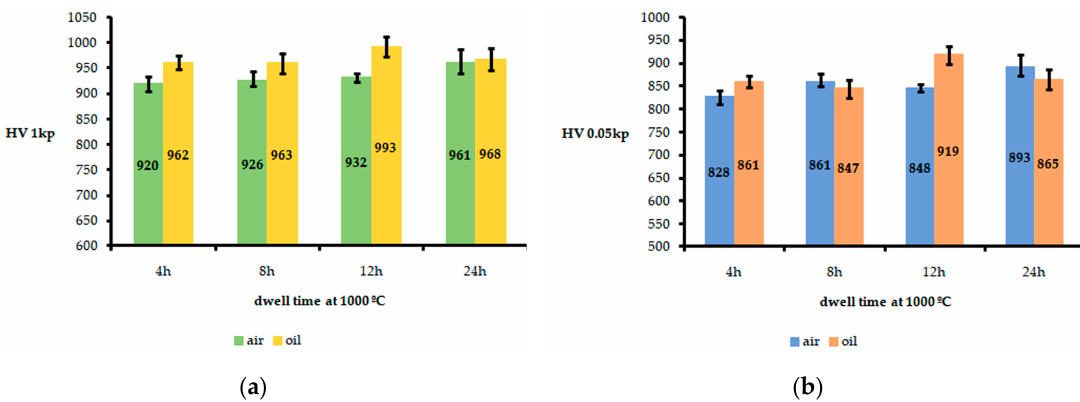
Figure 6. Hardness values. The error bars show the distance between the mean value and the maximum and minimum values. Ten (10) indentations were made in each sample; ( a ) hardness values obtained in the overall microstructure applying a 10 N load; ( b ) hardness values obtained in the constituent matrix applying a 0.5 N load.